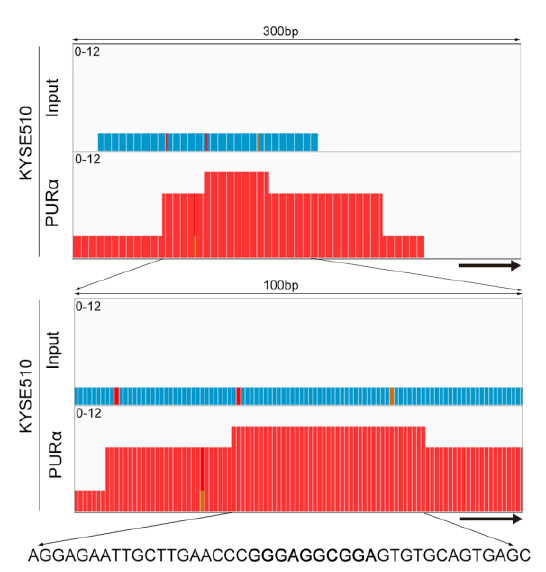
Figure 5. IGV visual analysis. Visual analysis of the PURα binding peak in the PCK2 promoter region from ChIP-seq of KYSE510-input/PURα cells by IGV. The arrows refer to the PCK2 gene.